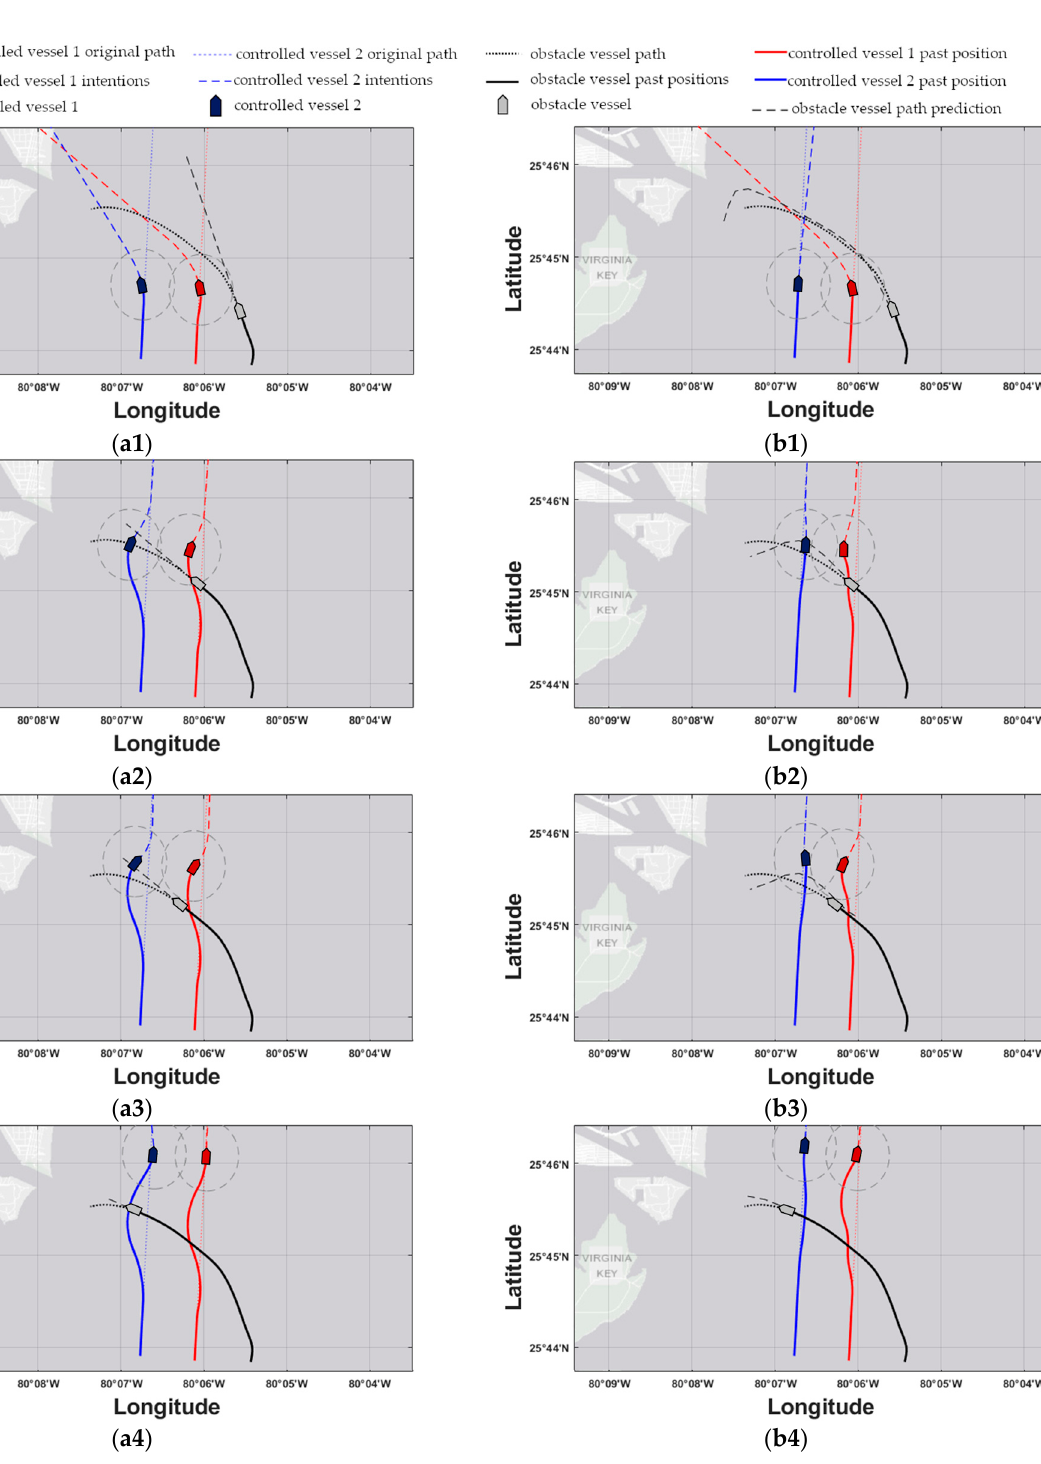
Figure 8. Scenario 2. The left subfigure column refers to the MPC-SLP scheme, while the right to the MPC-RBFP scheme. Subfigures ( a1, b1 ) refer to time instance 6 ′ , ( a2, b2 ) to 12 ′ , ( a3, b3 ) to 13.5 ′ , and finally, ( a4, b4 ) to 17 ′ .